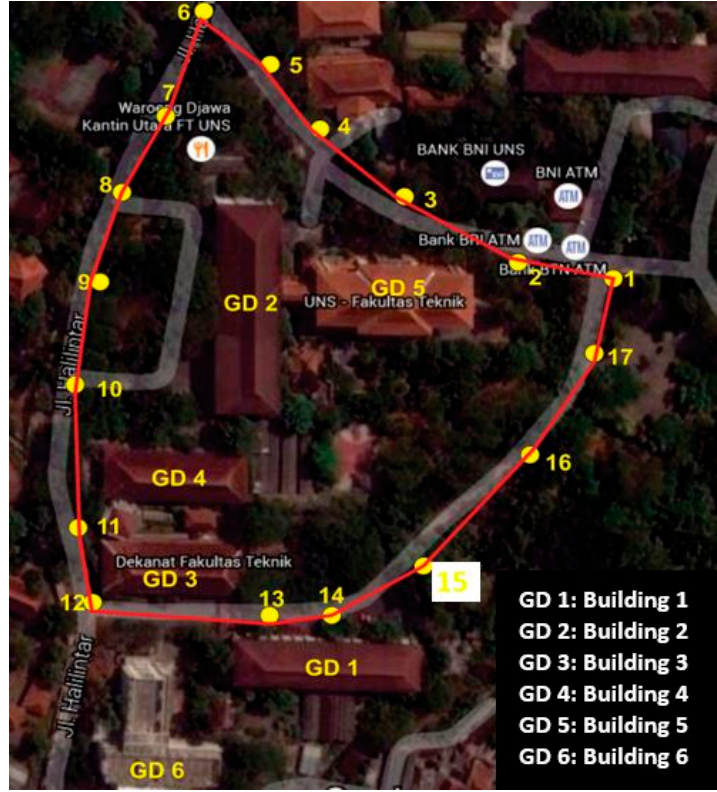
Figure 5. Street lighting location map.